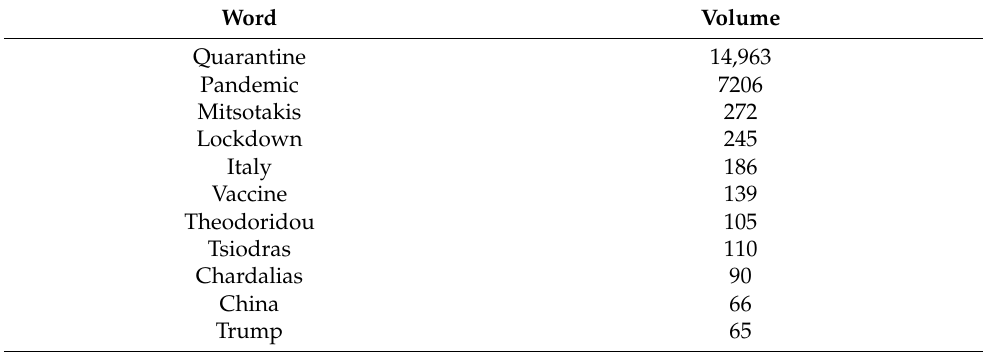
Table 4. Top 10 most frequently used words in tweets.